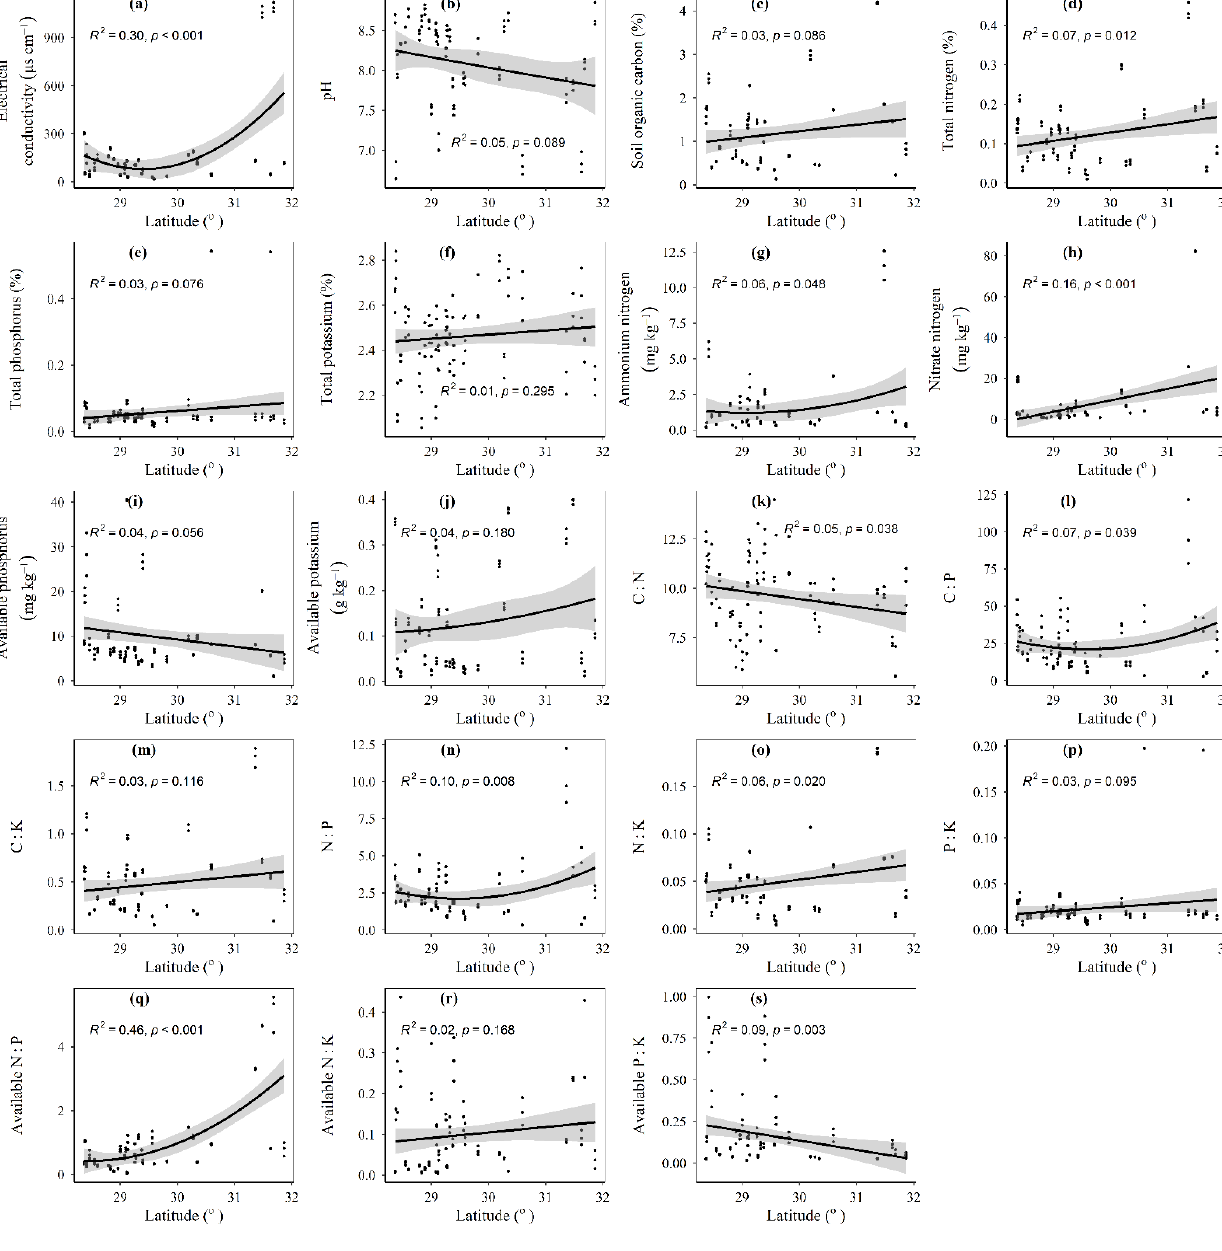
Figure A8. Relationships of latitude with soil ( a ) electrical conductivity, ( b ) pH, ( c ) soil organic carbon (SOC), ( d ) total nitrogen (TN), ( e ) total phosphorus (TP), ( f ) total potassium (TK), ( g ) ammonium nitrogen (NH 4+ -N), ( h ) nitrate nitrogen (NO 3 − -N), ( i ) available phosphorus (AP), ( j ) available potassium (AK), ( k ) ratio of SOC to TN (C:N), ( l ) ratio of SOC to TP (C:P), ( m ) ratio of SOC to TK (C:K), ( n ) ratio of TN to TP (N:P), ( o ) ratio of TN to TK (N:K), ( p ) ratio of TP to TK (P:K), ( q ) ratio of available nitrogen to AP (available N:P), ( r ) ratio of available nitrogen to AK (available N:K) and ( s ) ratio of AP to AK (available P:K) at a depth of 0–10 cm.